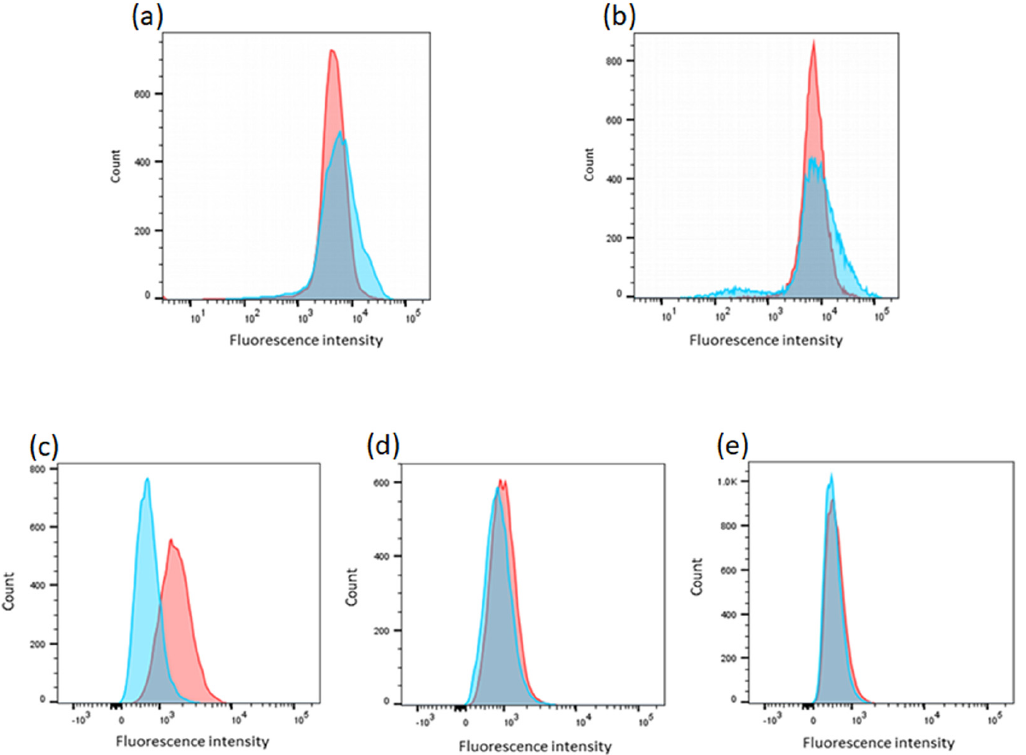
Figure 8. Visualization of calcium concentration and PMCA4 protein expression of K562 cells. ( a , b ) Visualization of calcium concentration of K562 WT (pink) and deleted cells (blue). An increased intracellular calcium concentration was displayed in clone ∆ ATP2B4_2 ( a ) and for clone ∆ ATP2B4_3 ( b ), respectively. ( c – e ) PMCA4 protein expression using flow cytometry analysis. Representative FACs plot illustrating isotype (blue) and JA9 (pink) peaks visualized by an APC conjugated secondary antibody in K562 WT cells ( c ), ∆ ATP2B4_2 deleted clone ( d ), and ∆ ATP2B4_3 deleted clone ( e ). These were visualized using FlowJo